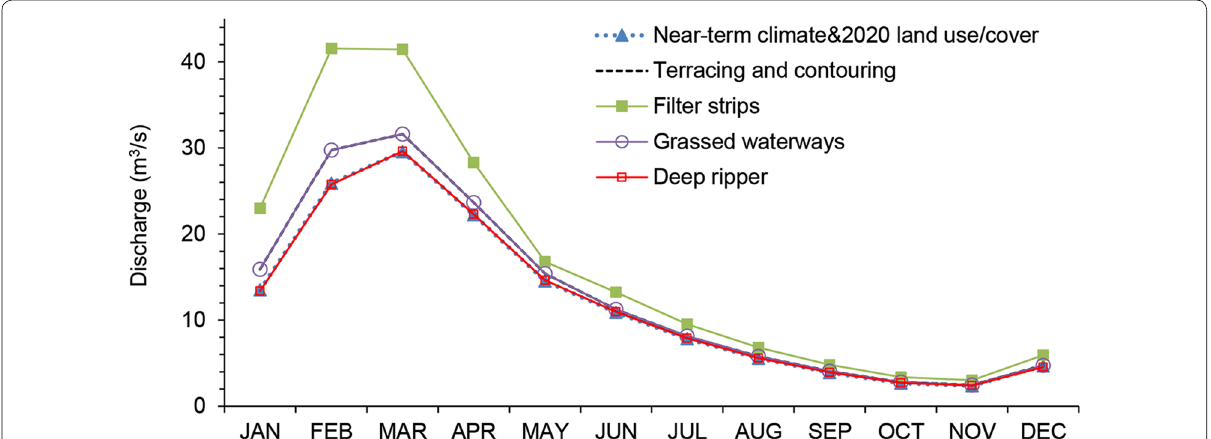
Fig. 24 Hydrographs of Ndembera River at 1ka33 under different land and water management practices compared the reference